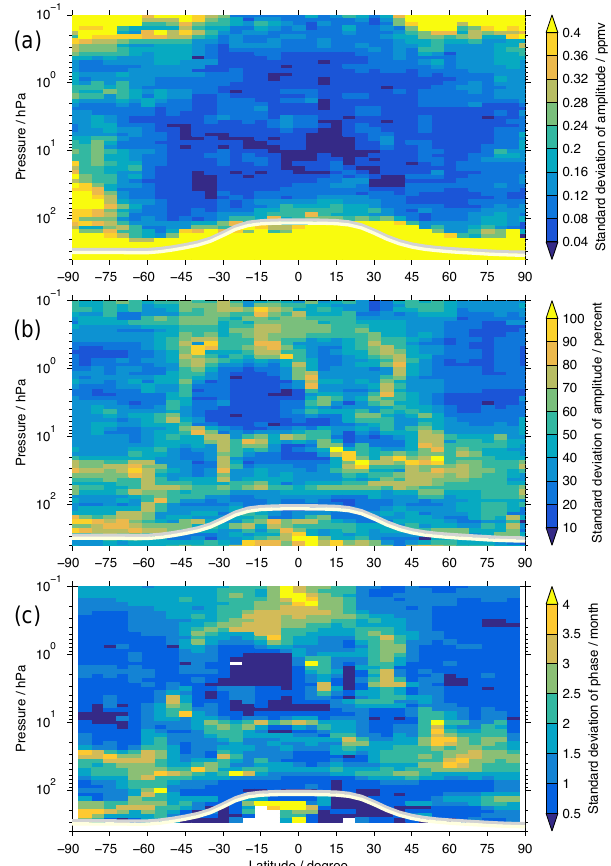
Figure 5. The typical uncertainties among the different data sets for the amplitude and phase of the annual variation. The upper panel shows the standard deviation for the amplitude in absolute terms σ( A ) while the middle panel considers the deviation in rel- ative terms σ rel ( A ) (with respect to the average over all data sets; see Eq. 6). The lower panel shows the standard deviation of the phase difference σ((cid:49) P ) with respect to the MLS data set. Some data screening has been applied to achieve meaningful results; see text for details. As in Fig. 1, the light grey and white lines indicate the mean MERRA tropopause for the time period